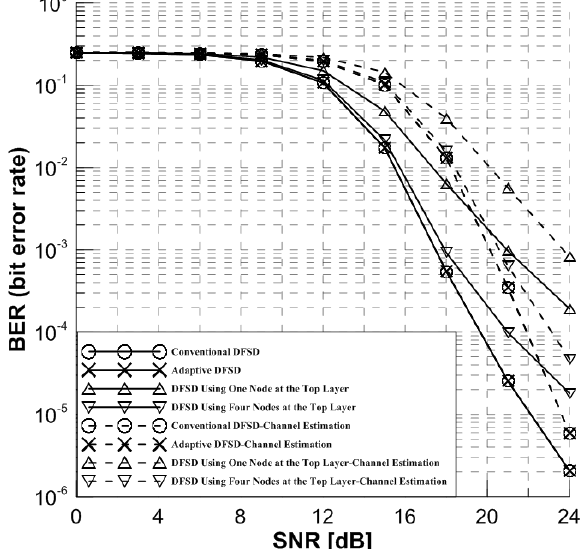
Figure 8. The error performance of the detection schemes with 16-QAM at the estimated channel. SNR: signal-to-noise ratio; BER: bit error rate.